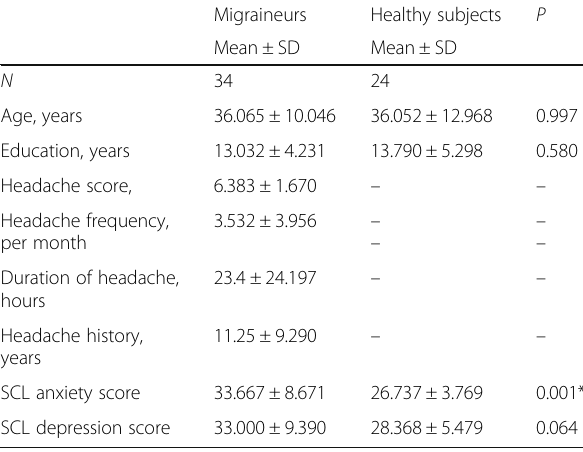
Table 1 Sample Characteristics